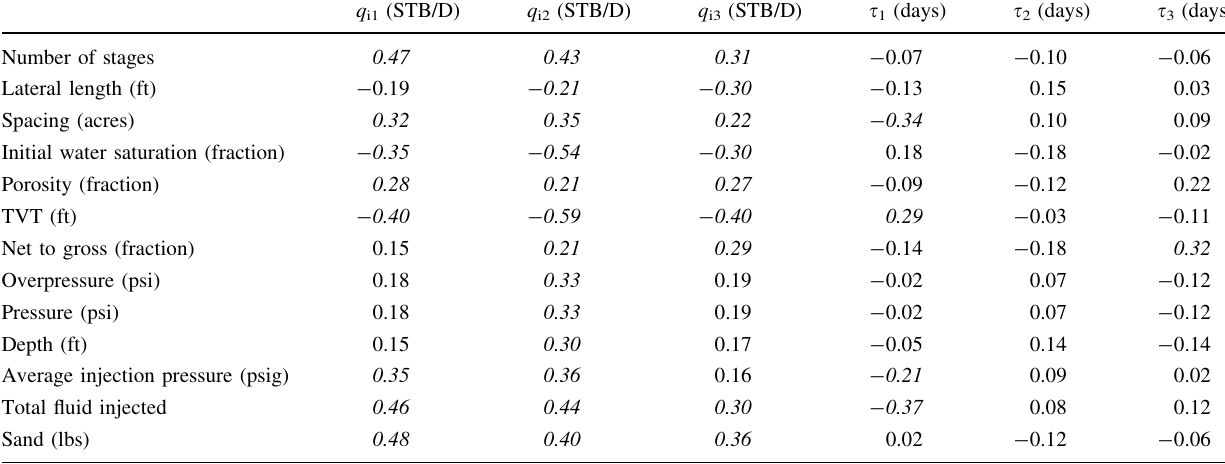
Table 5 Summary of the computed correlation coefficient between the model parameters and the reservoir and model completion properties for the parallel flow model q i1